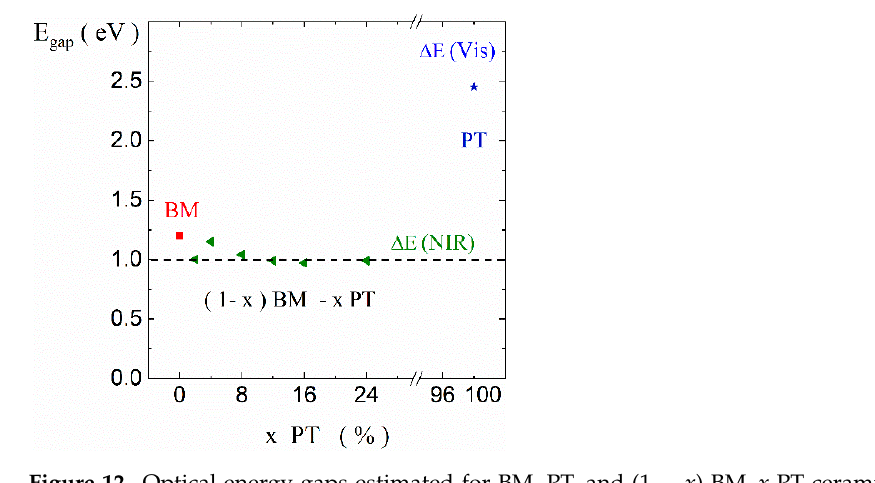
Figure 11. Modified Kubelka-Munk function ( α h ν ) 1/2 vs. photon energy h ν plot obtained for (1 − x)